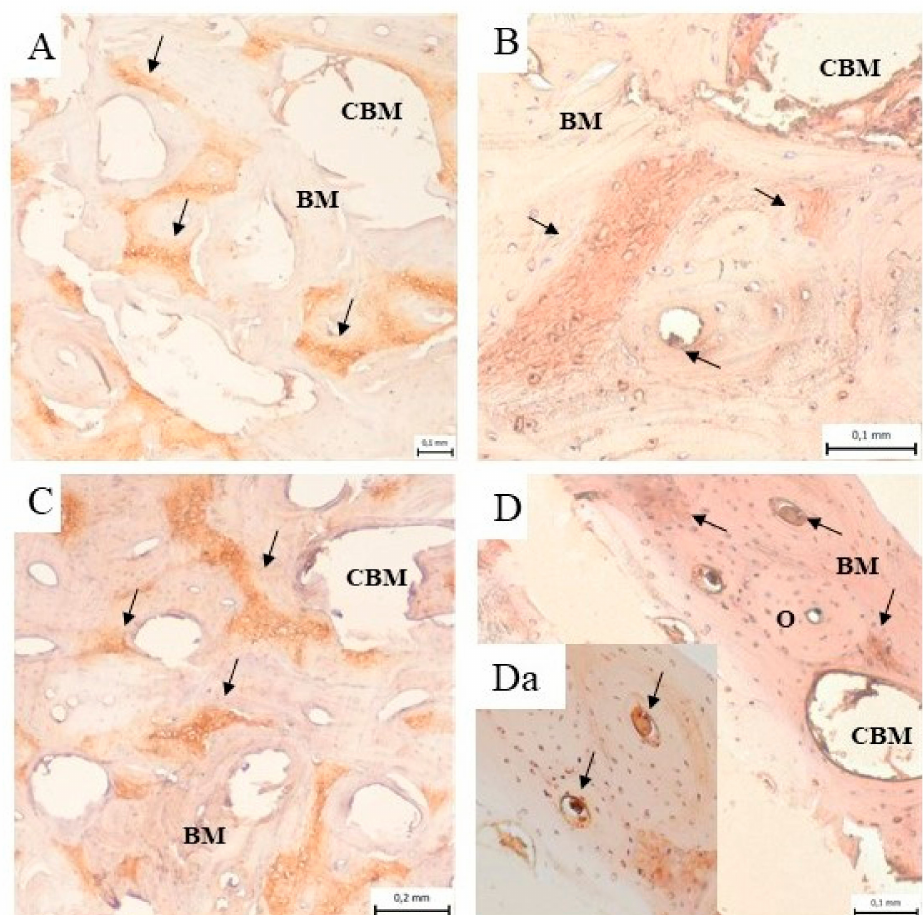
Figure 10. Immunohistochemical analysis of the samples from the cortical bone defect in a mandible treated with an HAP ceramic plate shows the presence of collagen I (black arrow) in the bone matrix (BM) of compact bone, in the spongy bone and around the bone marrow cavities (CMB) ( A ) 3 months, ( B ) 4 months, ( C ) 5 months and ( D ) 6 months after implantation. ( Da ) The presence of the expressed collagen I (black arrow) within and around the osteons